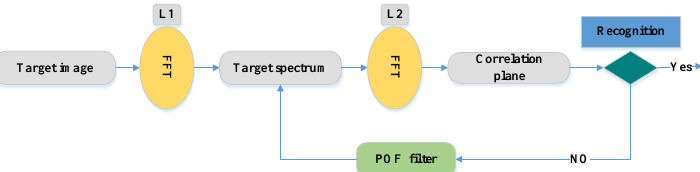
Figure 5. Flowchart of the VanderLugt correlator (VLC) technique [4]. FFT, fast Fourier transform; POF, phase-only filter.